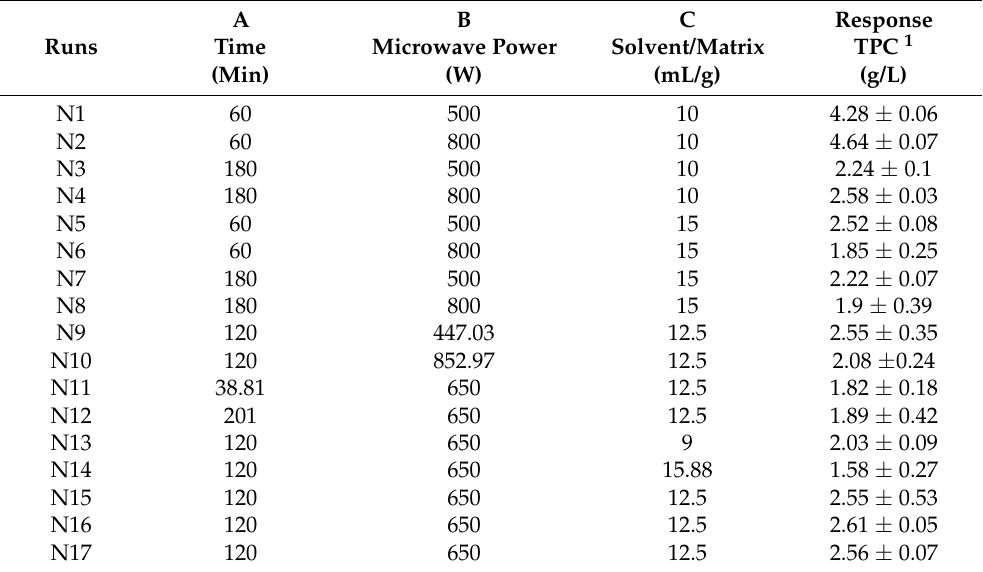
Table 1. Experimental design for the MAE of polyphenols from blackcurrant by-products. A, B, and C are the factors, and TPC is the optimized